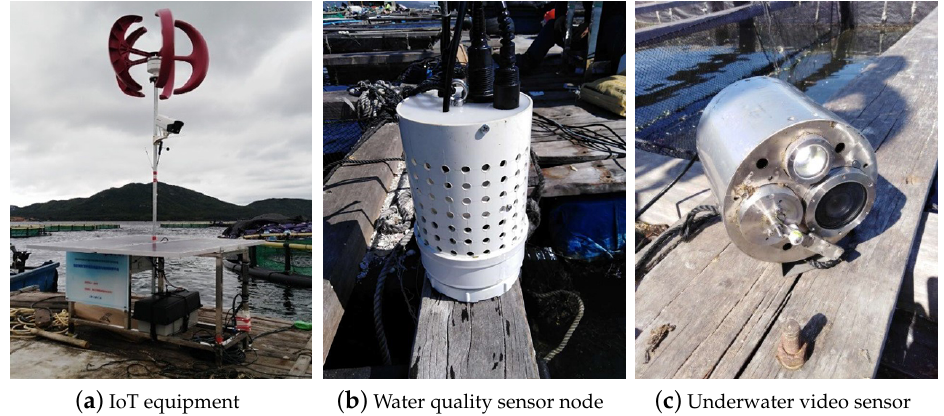
Figure 1. Experimental data acquisition site. ( a ) IoT equipment transmitted data to mobile phone and farmers can monitor water quality in real time. ( b ) Water quality sensor node collected water quality factor data such as water temperature, pH and dissolved oxygen. ( c ) Underwater video sensor collected and recorded underwater video data.